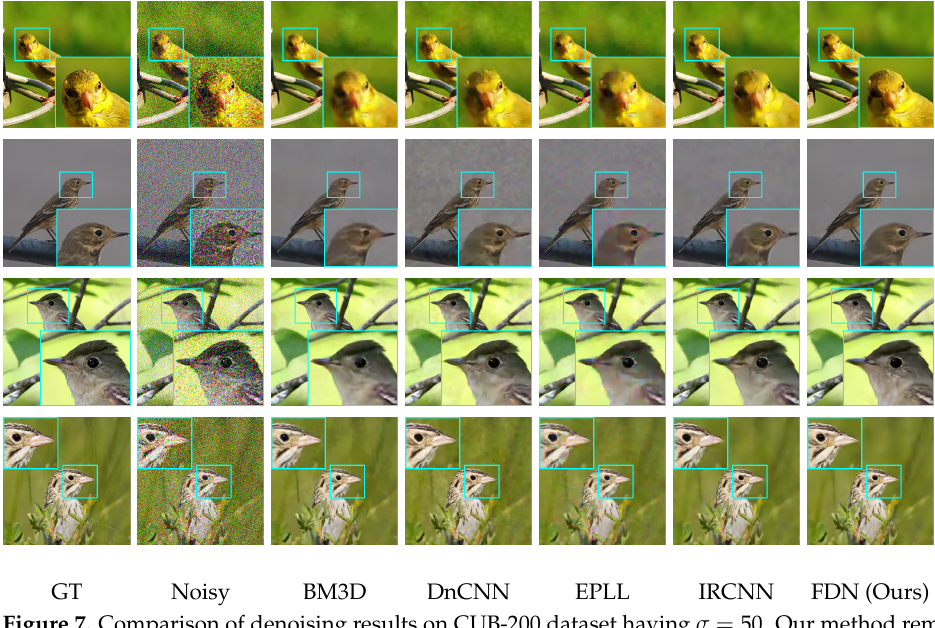
Figure 7. Comparison of denoising results on CUB-200 dataset having σ = 50. Our method removes artifacts and noise, providing clean edges and textures.